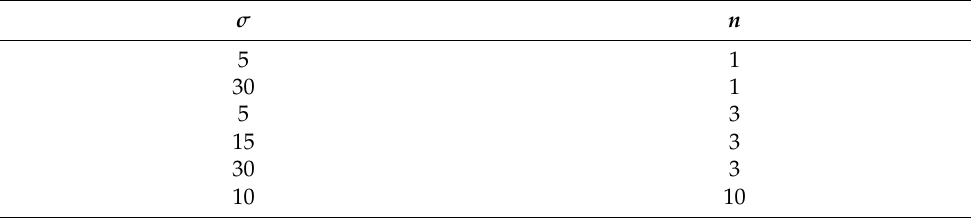
Table 1. Configuration of σ and n in